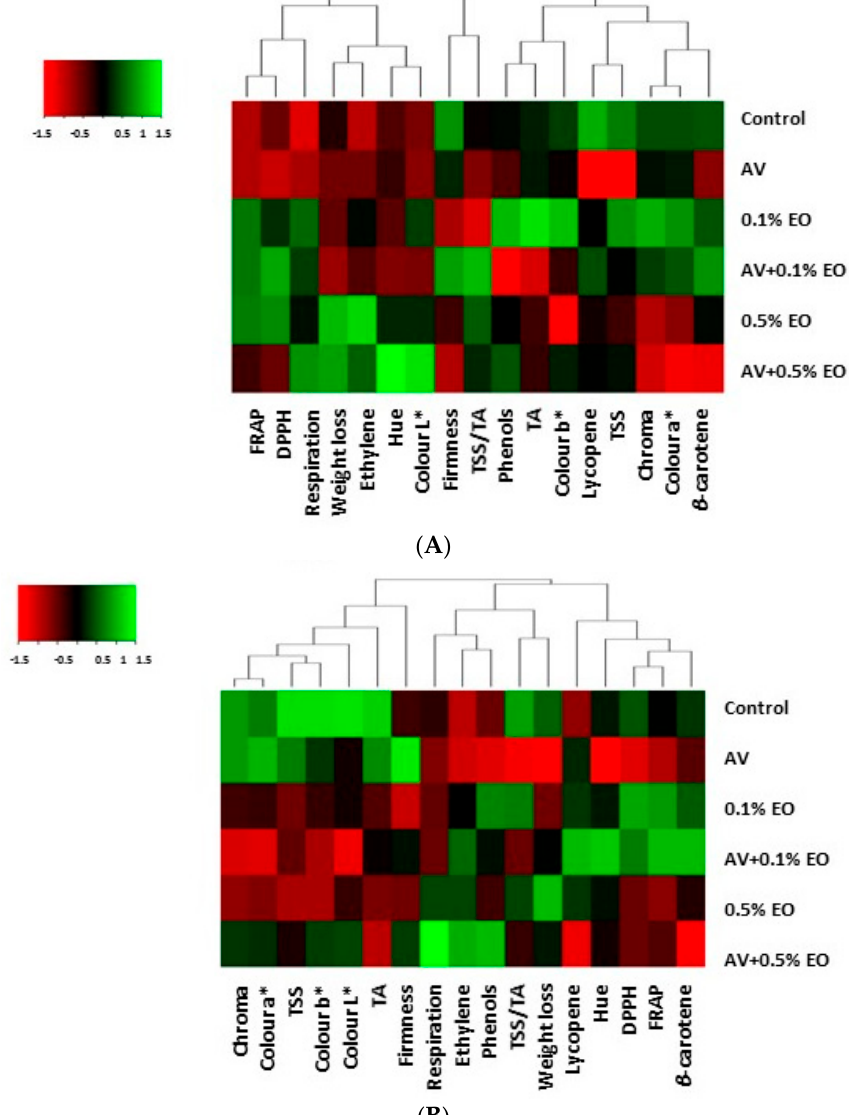
Figure 6. Quality changes in tomato fruit when subjected to Aloe vera (AV at 10%) coating and/or sage essential oil (EO at 0.1% and 0.5%). Heat map representing relative expression of postharvest performance elicited in tomato fruit following ( A ) 7 days and ( B ) 14 days of storage as compared to control fruits.